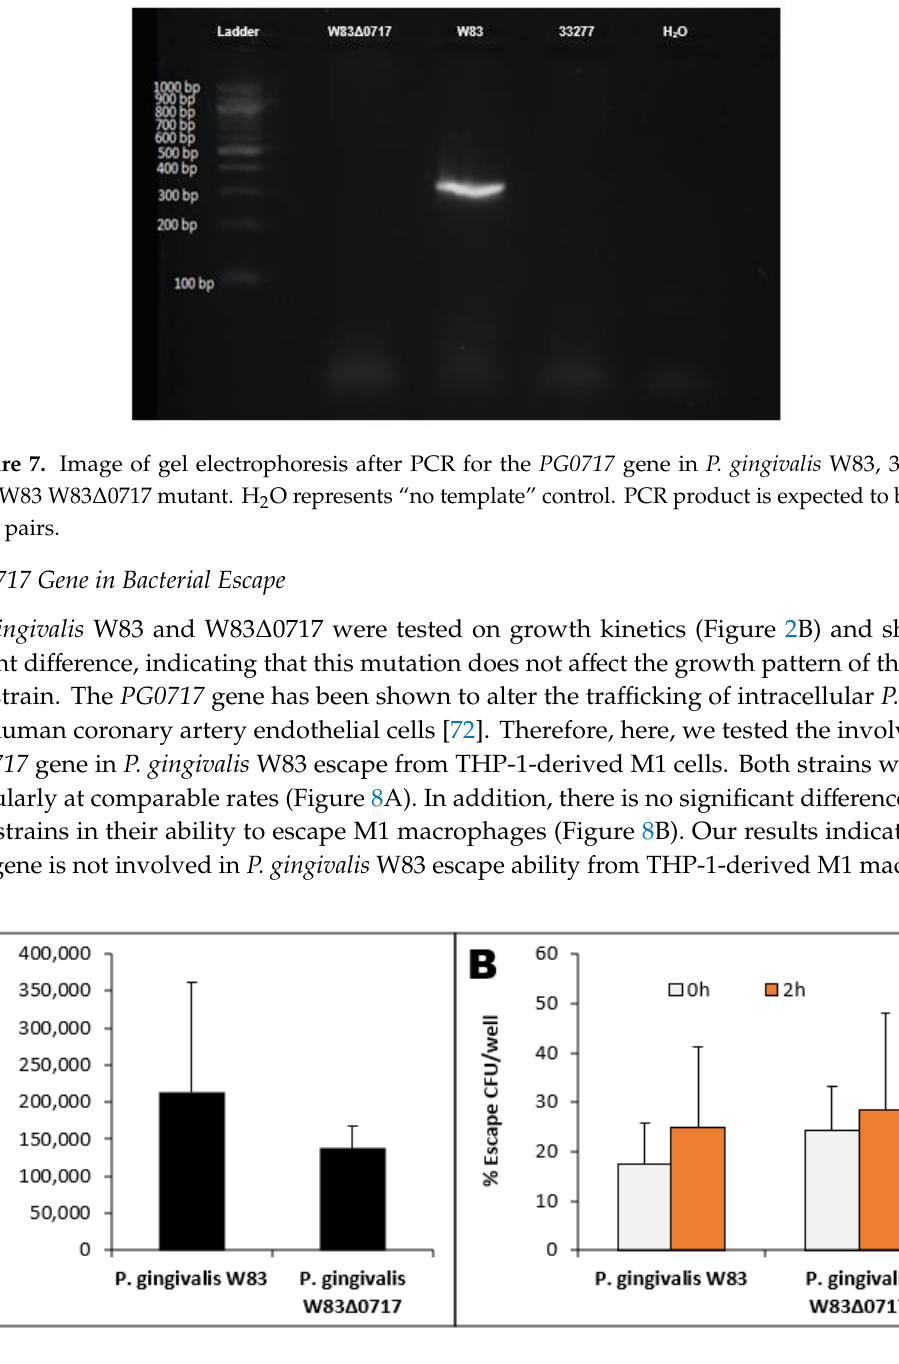
Figure 8. P. gingivalis W83 and W83 ∆ 0717 intracellular CFU counts ( A ) and % escape ( B ) from THP-1-derived M1